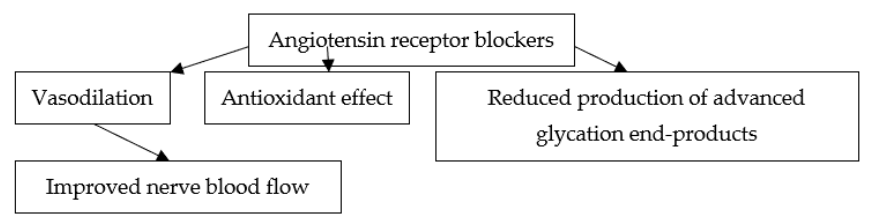
Figure 2. Major mechanisms potentially implicated in the beneficial effects of angiotensin receptor blockers on diabetic neuropathy.